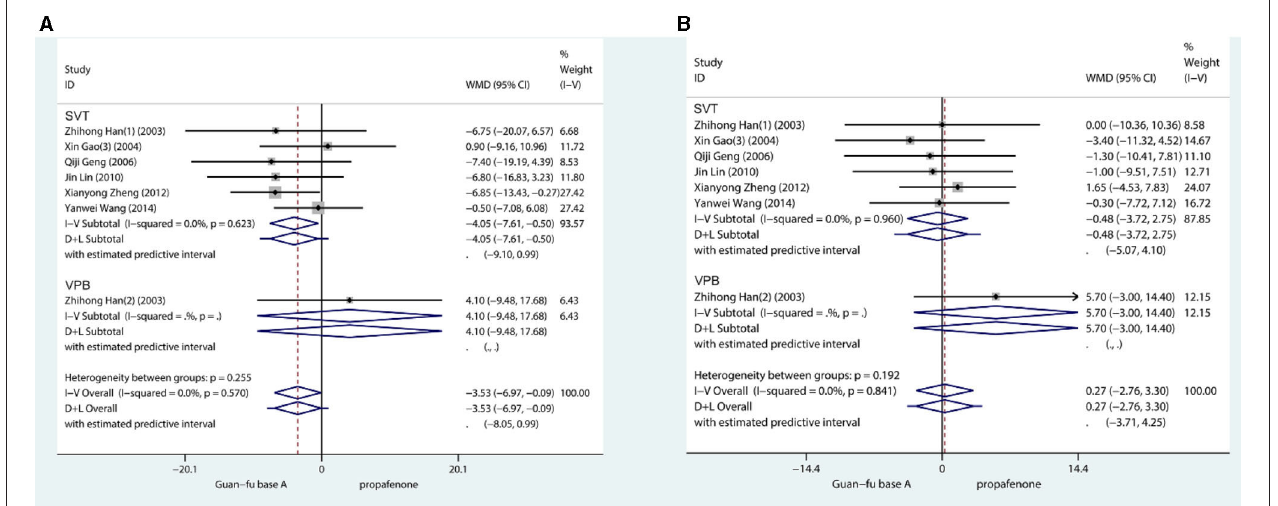
FIGURE 3 | Forest plot comparing the GFA with propafenone in blood pressure. (A) Forest plot comparing the GFA with Propafenone in systolic blood pressure. (B) Forest plot comparing the GFA with Propafenone in diastolic blood pressure.